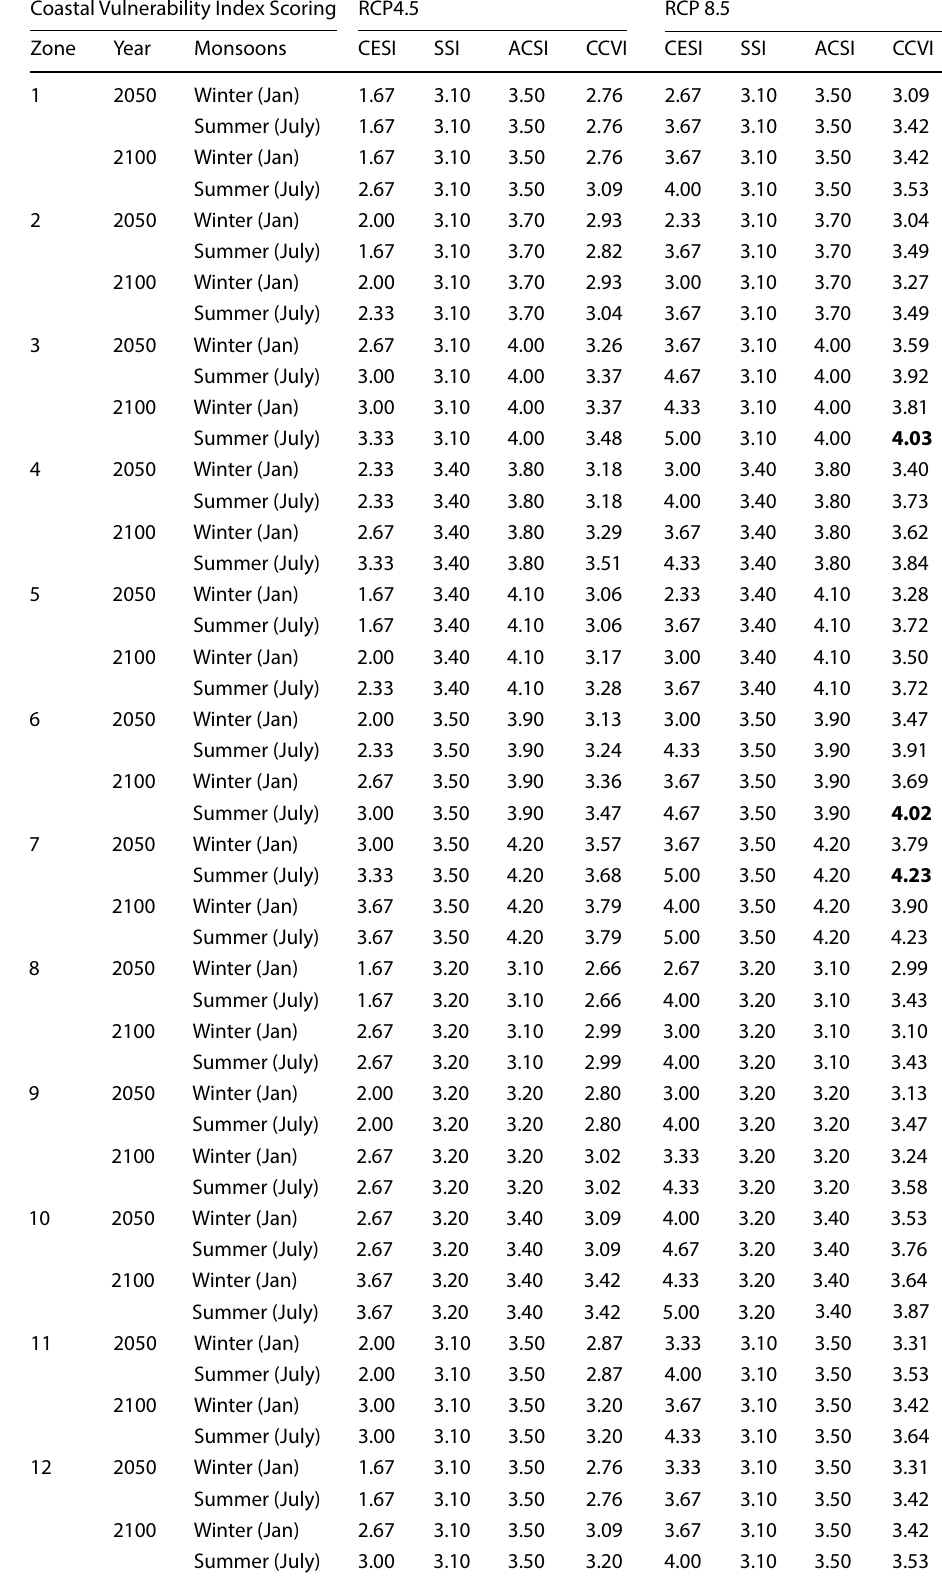
Table 8 Climate Change Vulnerability Index (CCVI) for each zone under climate projection of RCP 4.5 and